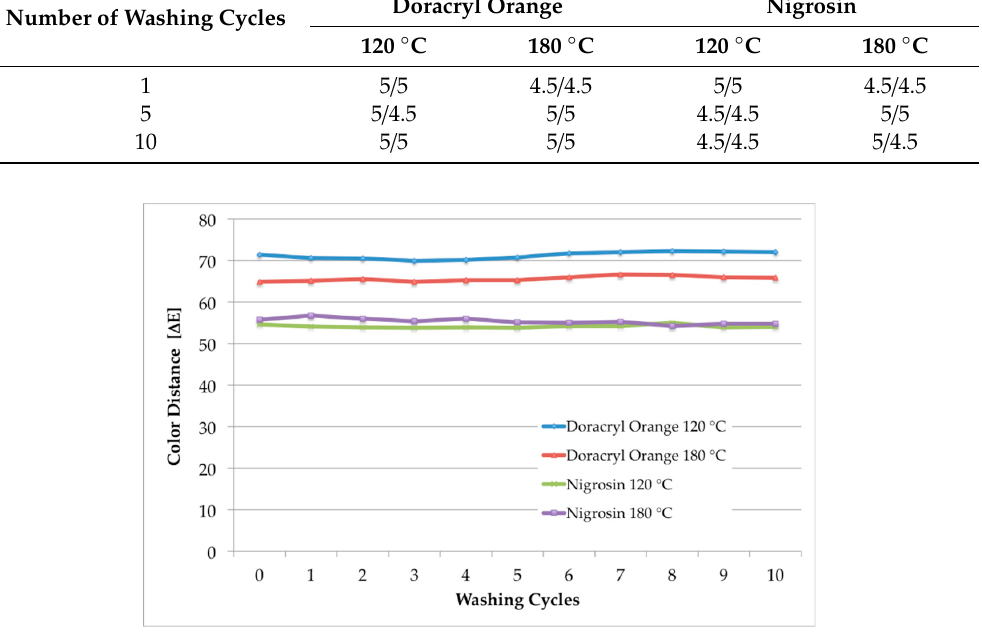
Table 3. Fastness to light of conventionally dyed m-aramid fibers.